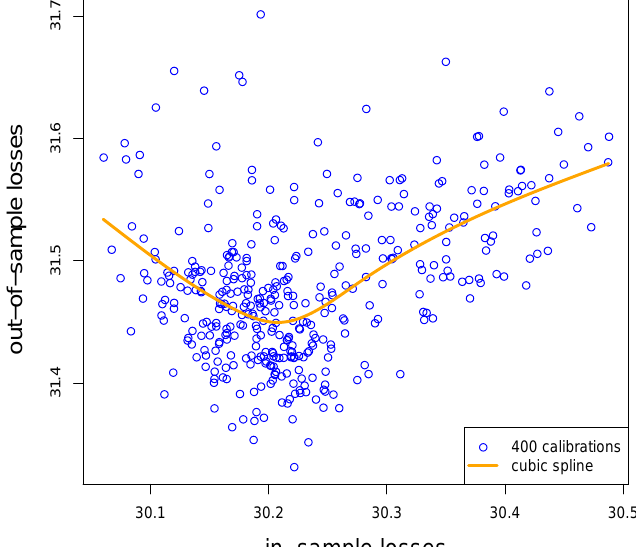
Figure 3. Scatter plot of in-sample losses versus out-of-sample losses over 400 different runs of the gradient descent algorithm with different seeds j = 1, . . . ,400, the orange line provides a cubic spline